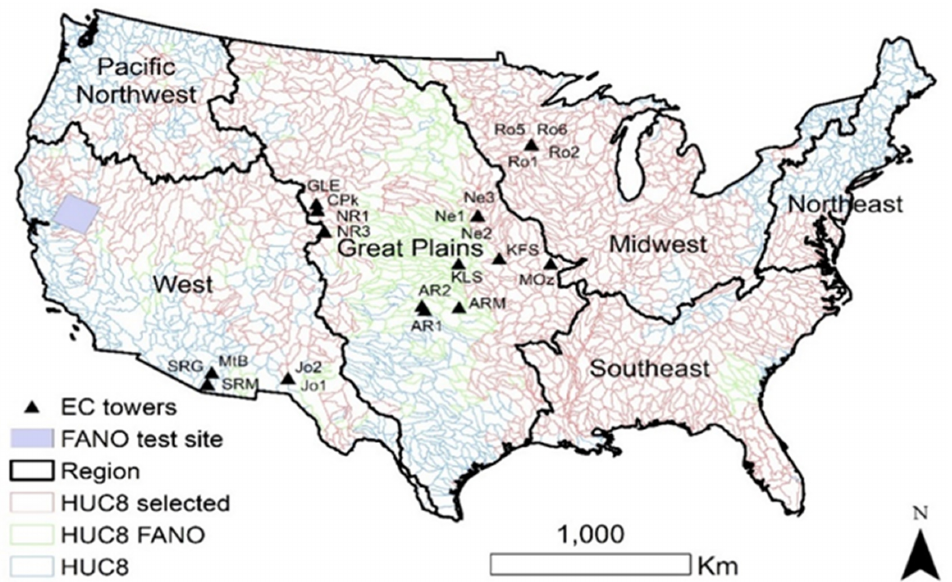
Figure 1. Location of eddy covariance (EC) towers used in this study; qualified eight-digit Hydro- logical Unit Code (HUC8 selected, HUC8 FANO) boundaries for the one-to-one evaluation of two versions (v0.1.7 and v0.2.6, respectively) of SSEBop model (red, HUC8 selected) and additional qual- ified HUC8 with SSEBop v0.2.6 alone (green, HUC8 FANO); unqualified watersheds for water bal- ance-based ET evaluation are shown in blue (HUC8). FANO procedure test site covering the west- ern part of Nevada (Landsat path/row: 043/033) along with the six regions of the conterminous United States are displayed.